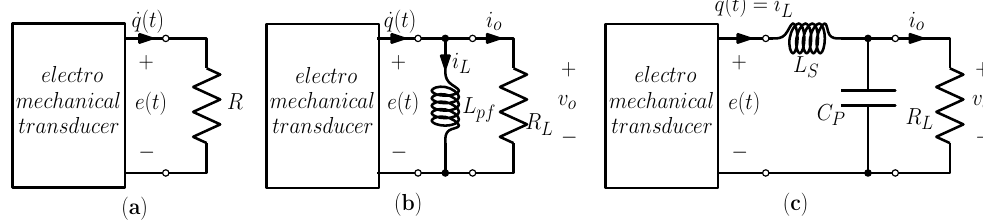
Figure 6. Different types of load. ( a ) Resistive load. ( b ) Power-factor corrected load for a piezoelectric energy harvester. ( c ) Low-pass, L -matching network.